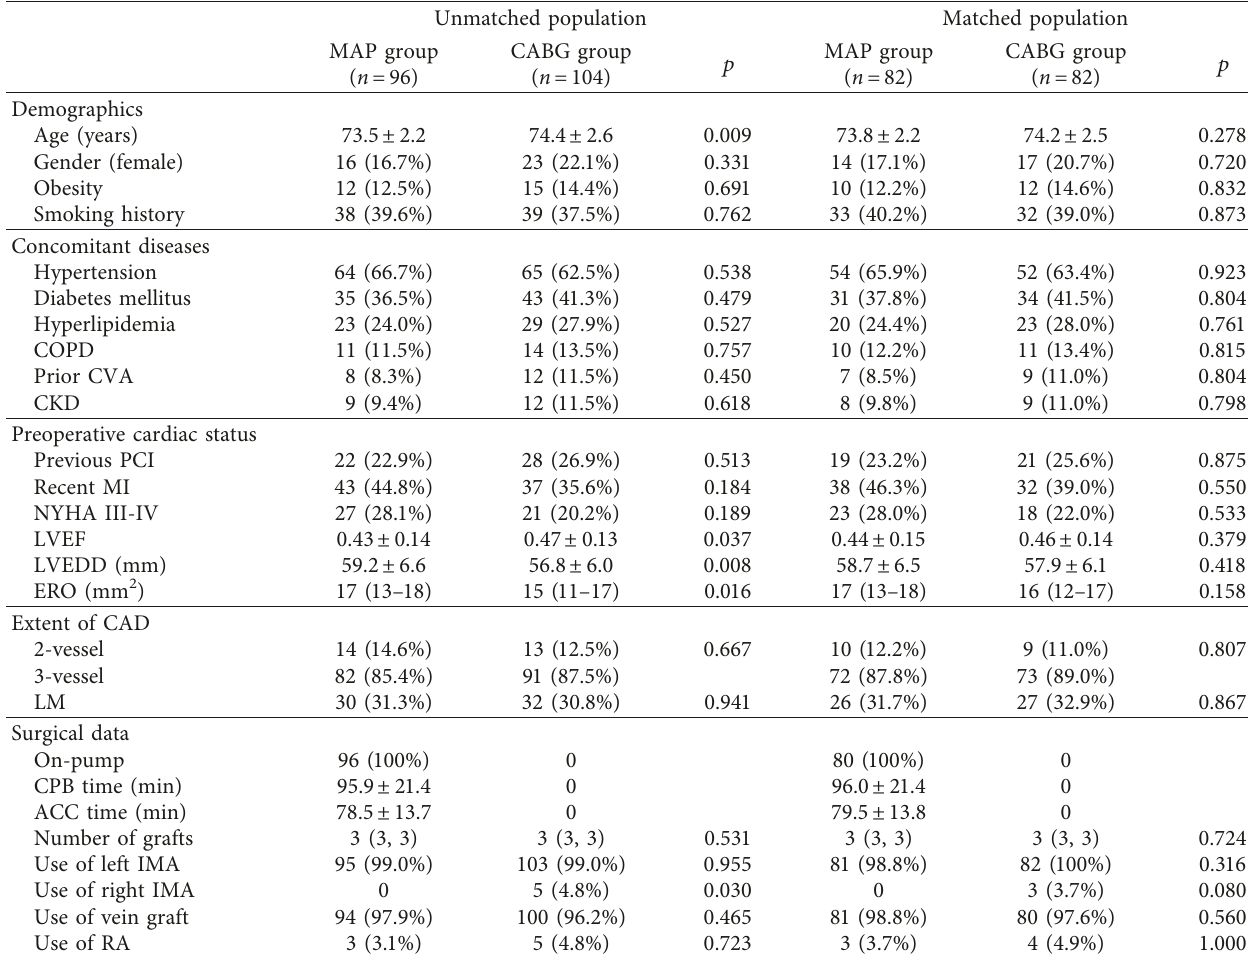
Table 1: Baseline and procedure characteristics.